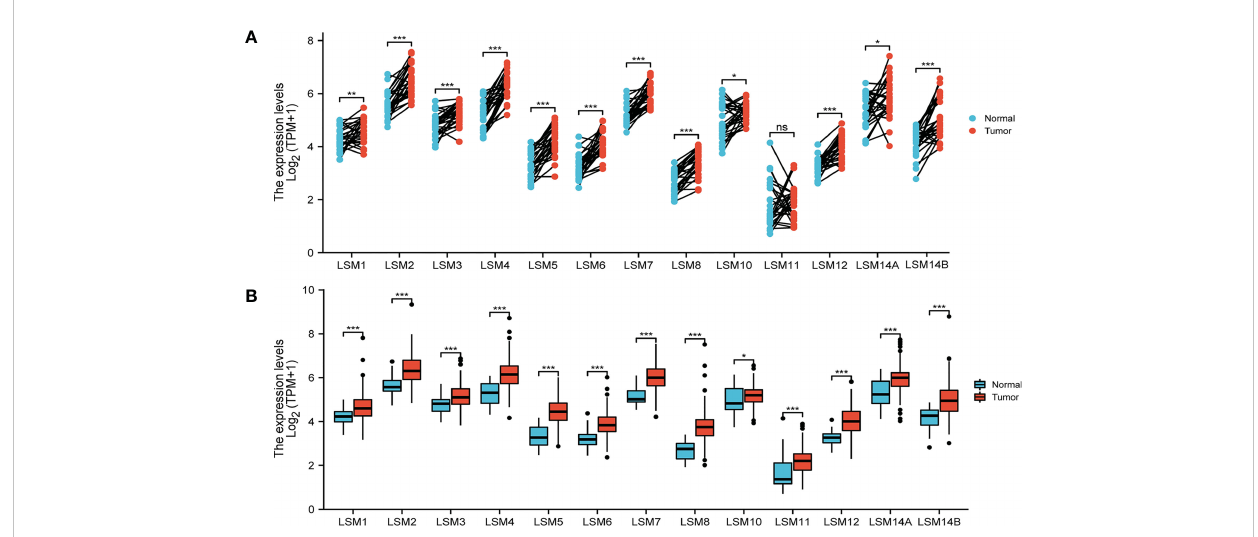
FIGURE 1 Expression level of 13 LSM members signi fi cantly up-regulated in GC by TCGA database analysis. (A) The expression level of LSM family members in gastric cancer tissues and their paired normal tissues. (B) The expression level of LSM family members in gastric cancer tissues and their unmatched normal tissues. TCGA database (https://portal.gdc.cancer.gov/); ns, p ≥ 0.05; *p < 0.05; **p < 0.01; *** p <